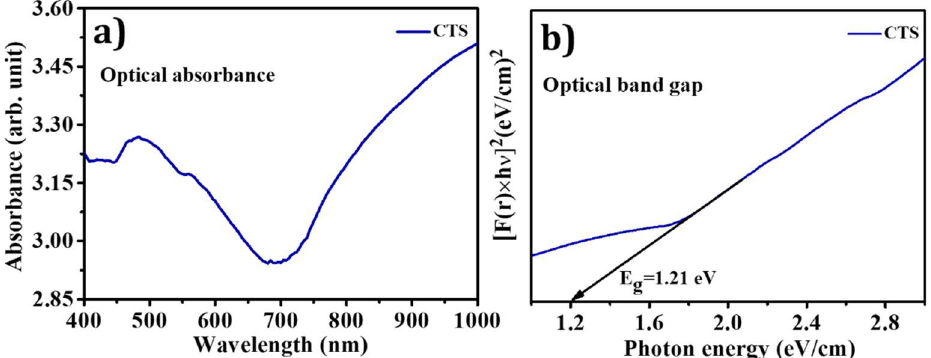
Figure 6. ( a ) Optical absorption spectrum and ( b ) optical band gap plot of CTS NPs.